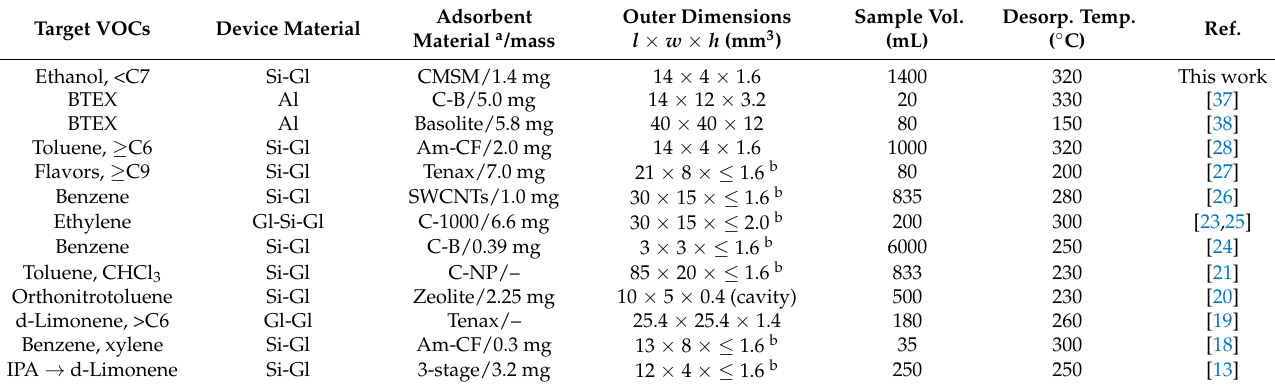
Table 1. Summary of the miniaturized preconcentrator for organic vapor